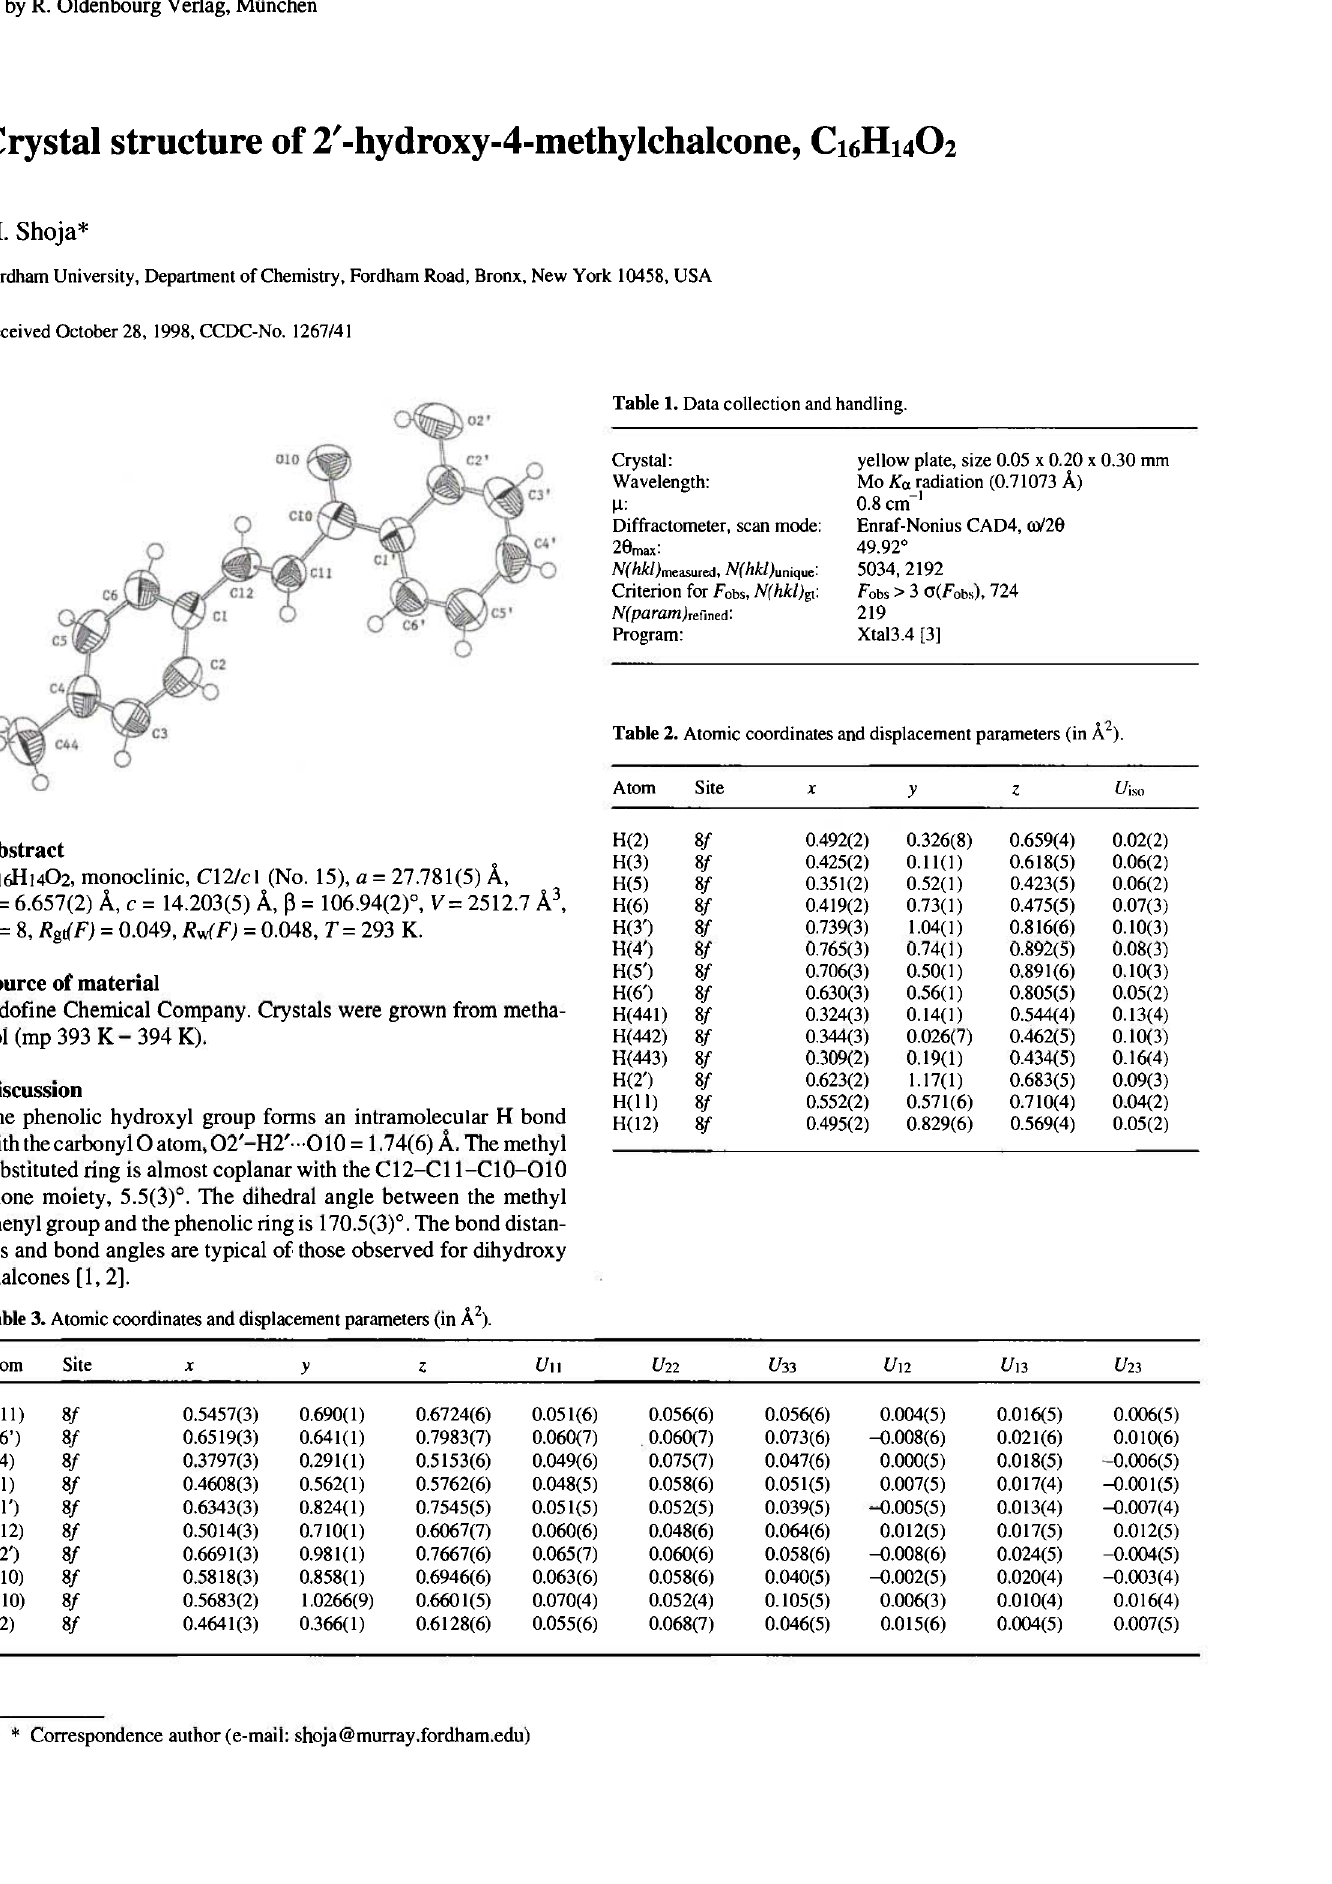
Table 1. Data collection and handling.